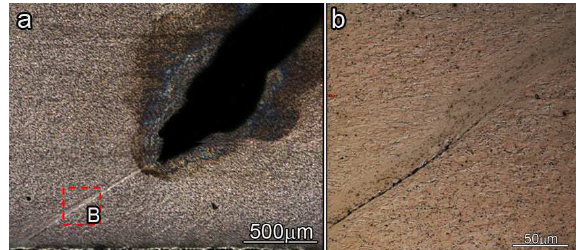
Fig. 3. CLSM images of TBs in zirconium alloy deformed at a strain of 0.30 and a strain rate of 2300 s -1 : (a) macroscopic CLSM images of TBs, (b) high magnified CLSM image of